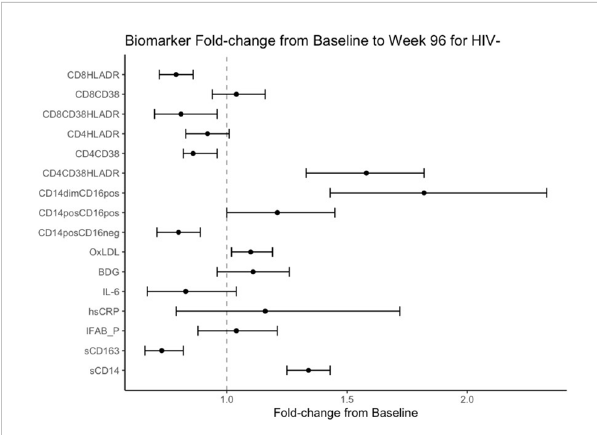
FIGURE 2 Fold Change from baseline over 96 weeks in HIV- participants. Point estimates and error bars re fl ect mean and 95% con fi dence